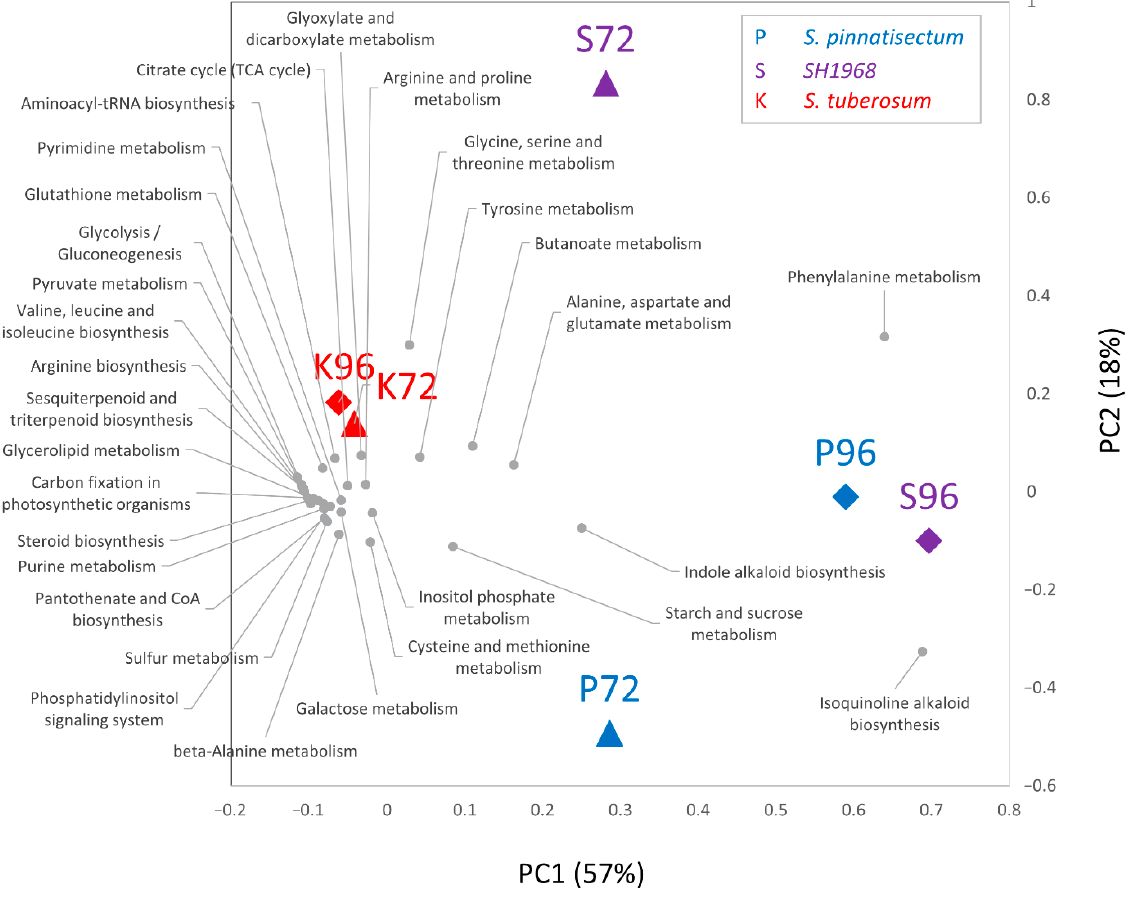
Figure 4. Metabolomic response to inoculation. The metabolic pathway impact based on 72 differentially abundant metabolites identified with confident identification, evaluated by MetaboAnalyst 5.0 [28], and visualized by PCA.